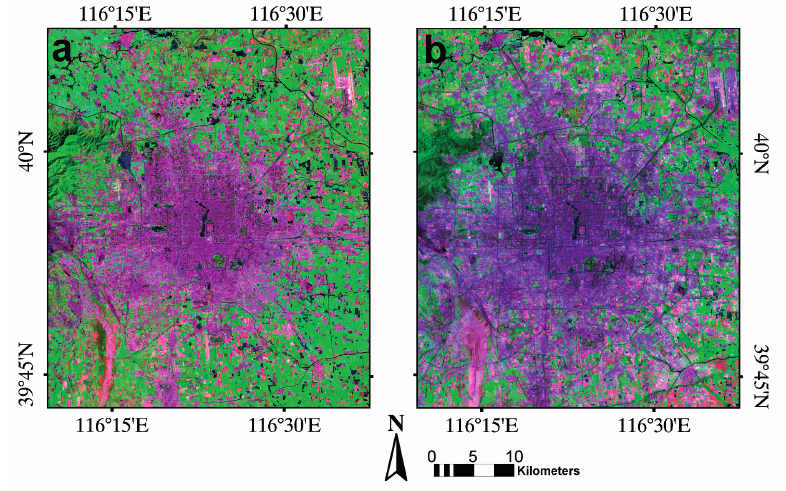
Figure 2. Landsat TM images of the Beijing study area (7, 4 and 2 bands as R, G and B) acquired in 1995 ( a ) and 2005 ( b